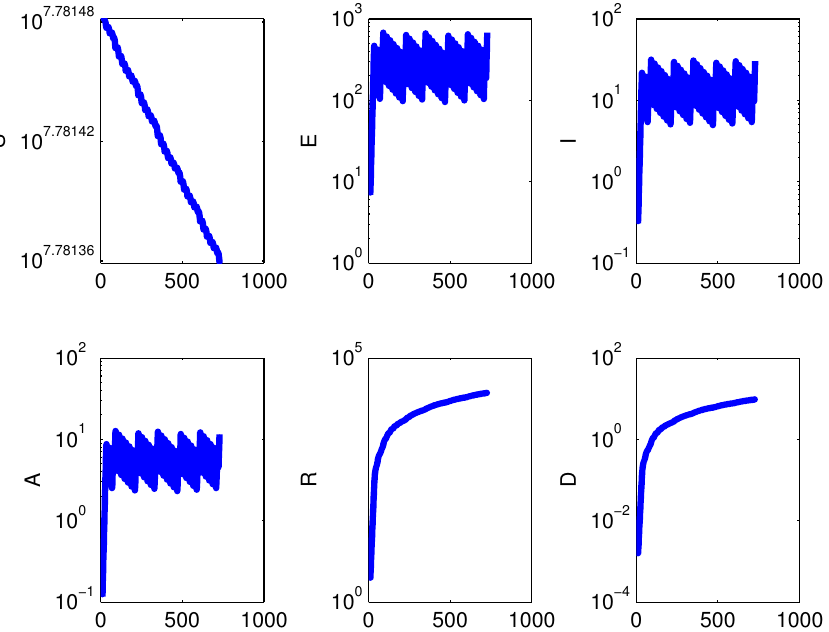
Figure 14. Using a semilogarithmic scale for the vertical axis, we show the results of the intermittent lock-down policy. Here the population is checked every week, starting after a week. If the number of infected is above a small threshold (here taken to be 10) the reduced contact rate β I = 10 − 10 is resumed for a week. The simulation runs over two years timespan for the model with demographics (1). Left to right and top to bottom, the subpopulations are: S , E , I , A , R and D , the disease-related deceased